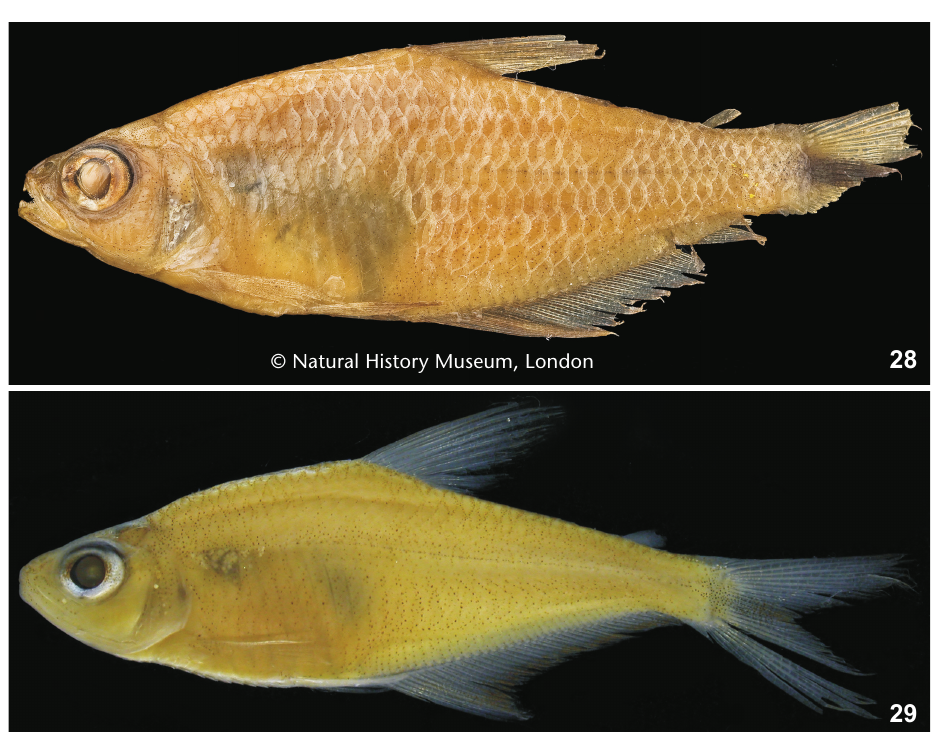
Figuras 28-29. Phenacogaster carteri: (28) BMNH 1934.9.12:216, holótipo, 36,4 mm CP, afluente do Rio Cuyuni, Guiana, (29) UF 78040, 30,4 mm CP, confluência dos rios Caura e Erebato, sistema do Rio Orinoco, Venezuela.